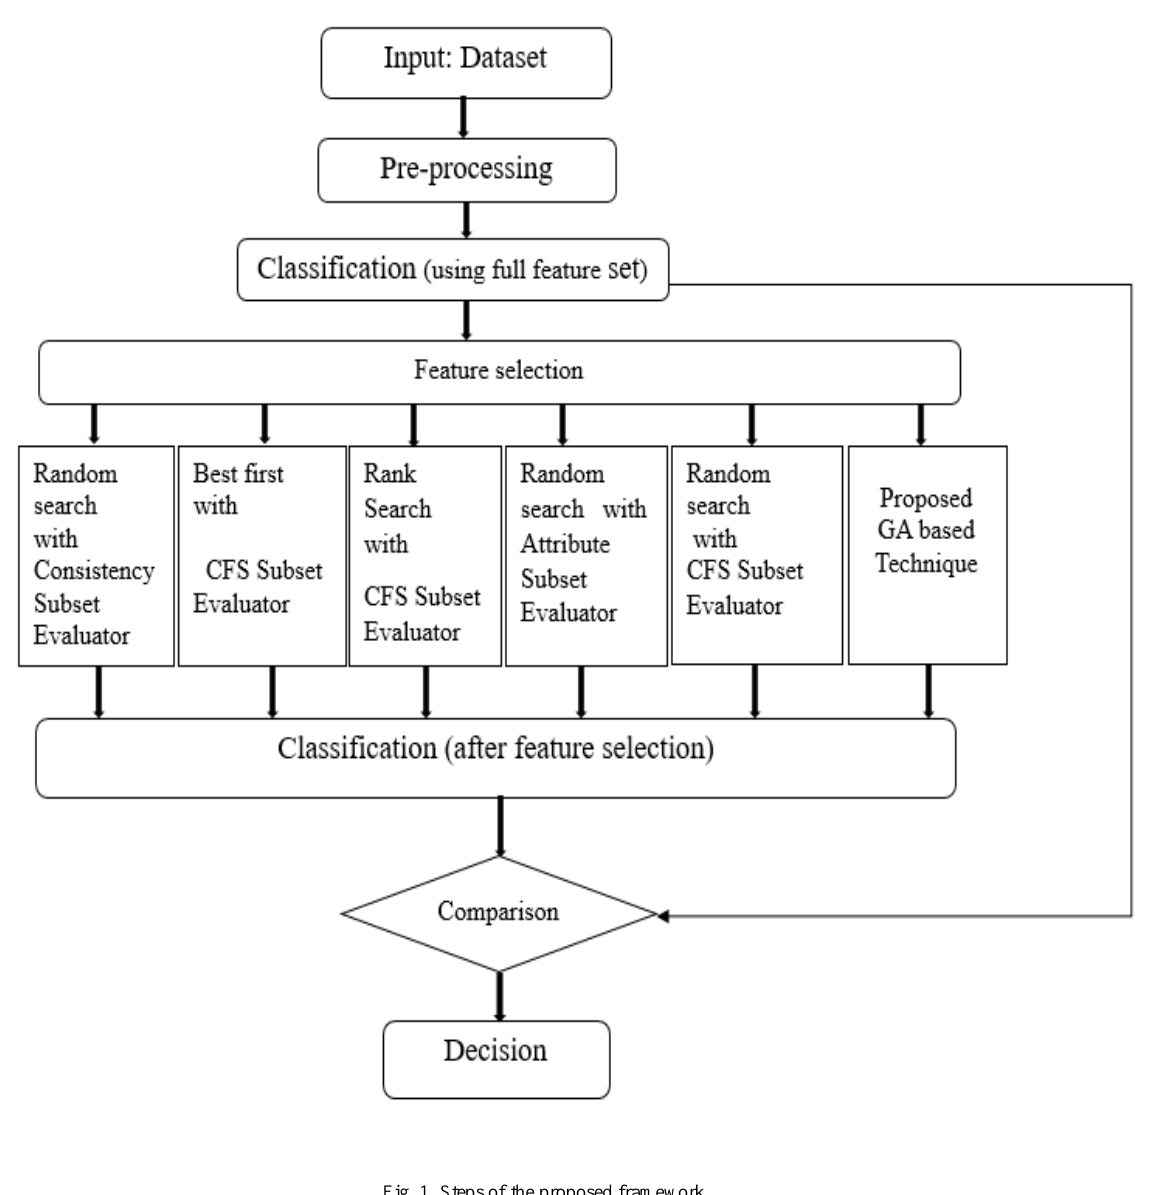
Fig. 1. Steps of the proposed